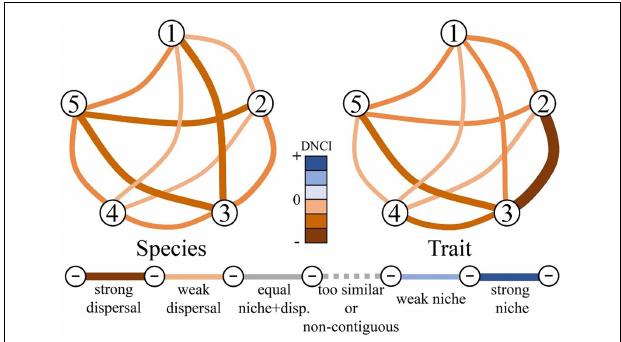
FIGURE 3 | Dispersal-niche continuum index (DNCI) value calculated based on species and trait. The overall and pairwise analysis are pictured as a colored gradient bar and network plots, respectively. The width and color of the links between nodes correspond to assembly process intensity. The darker and wider the link, the stronger the assembly process. The figure on the left is based on species, whereas figure on the right is based on trait. (cid:192) – (cid:196) corresponds to